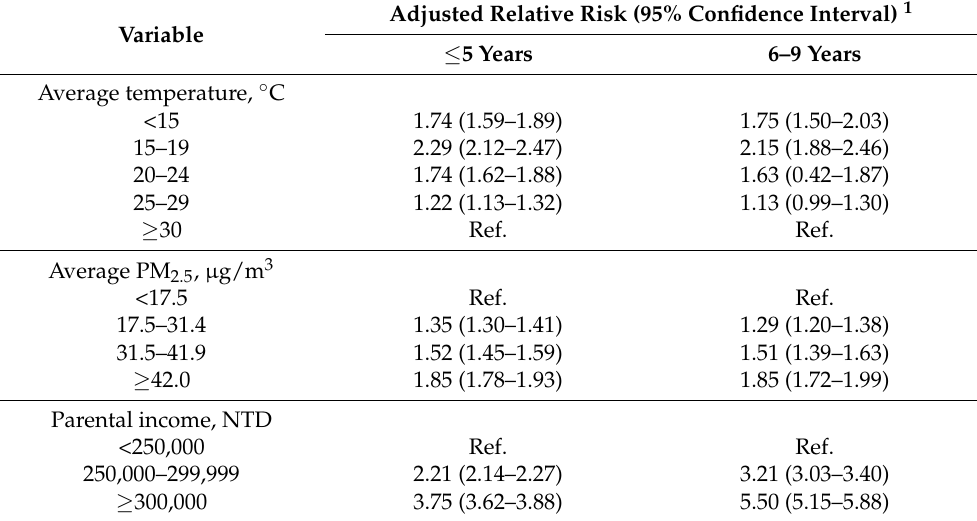
Table 2. Multivariable Poisson regression analysis estimated relative risk of rotavirus infection by temperature, PM 2.5 , parental annual income, and